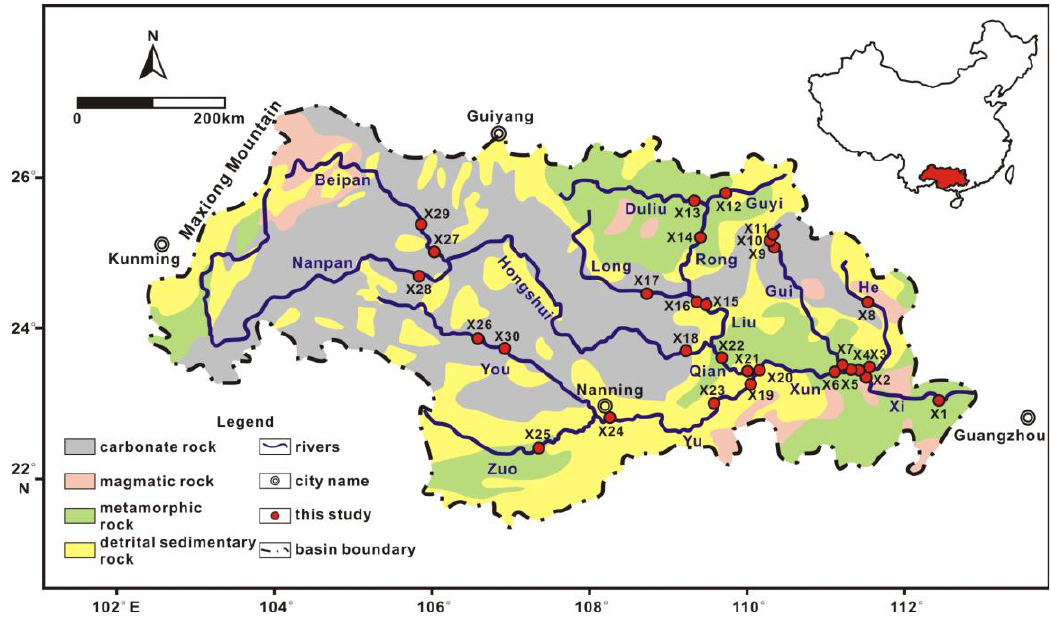
Figure 1. Geological map of the Xi River Basin and sampling locations [21].